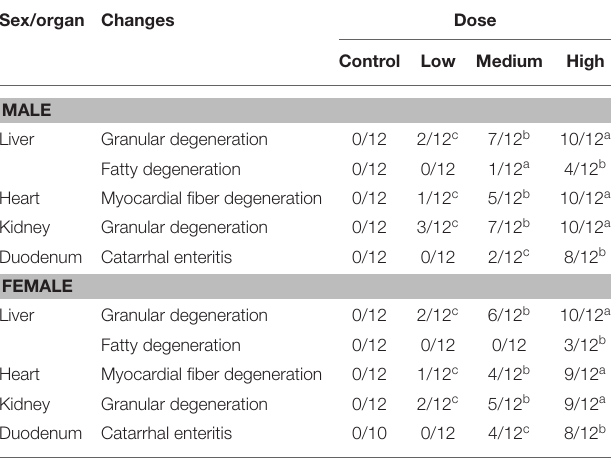
TABLE 5 | Histopathology results of organs in rats treated with oxyclozanide for 28 days. Sex/organ